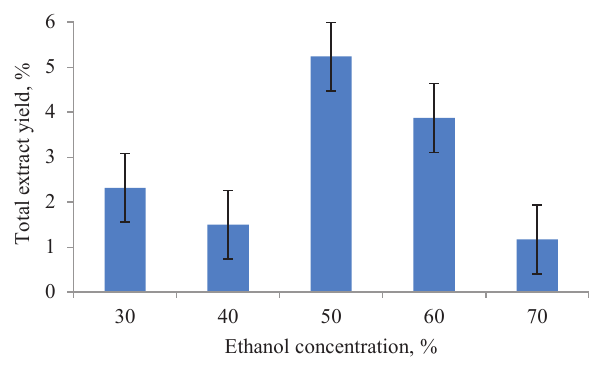
Figure 2 Solvents efficiency in extracting biologically active substances from ginseng callus cultures